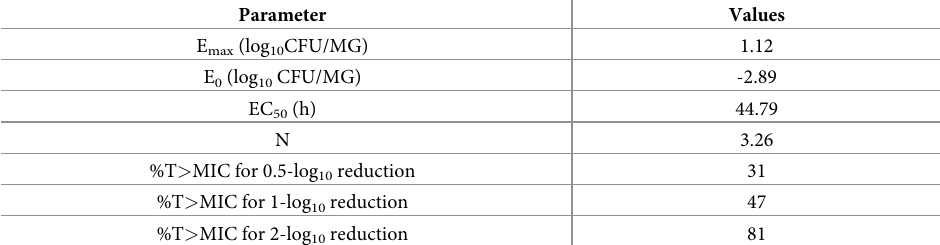
Table 3. The key PK/PD parameters for %T > MIC to achieve different antibacterial effects. Parameter